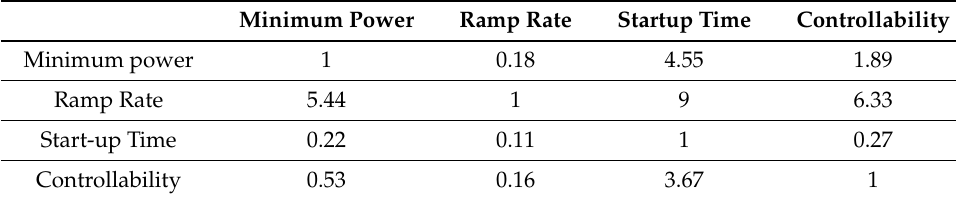
Table 9. Pairwise comparison matrix with respect to goal.